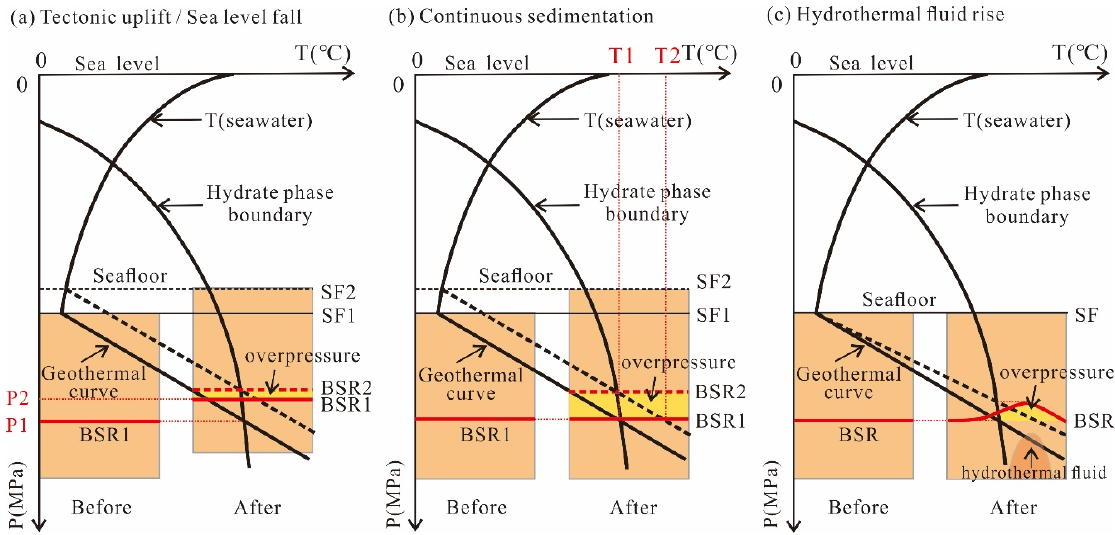
Figure 7. Overpressure development associated with hydrate decomposition due to tectonic up- lift/Sea level fall, continuous sedimentation, hydrothermal fluid rise (modified from Foucher et al. [29]). T, temperature ; P, pressure; SF, seafloor; BSR, bottom-simulating